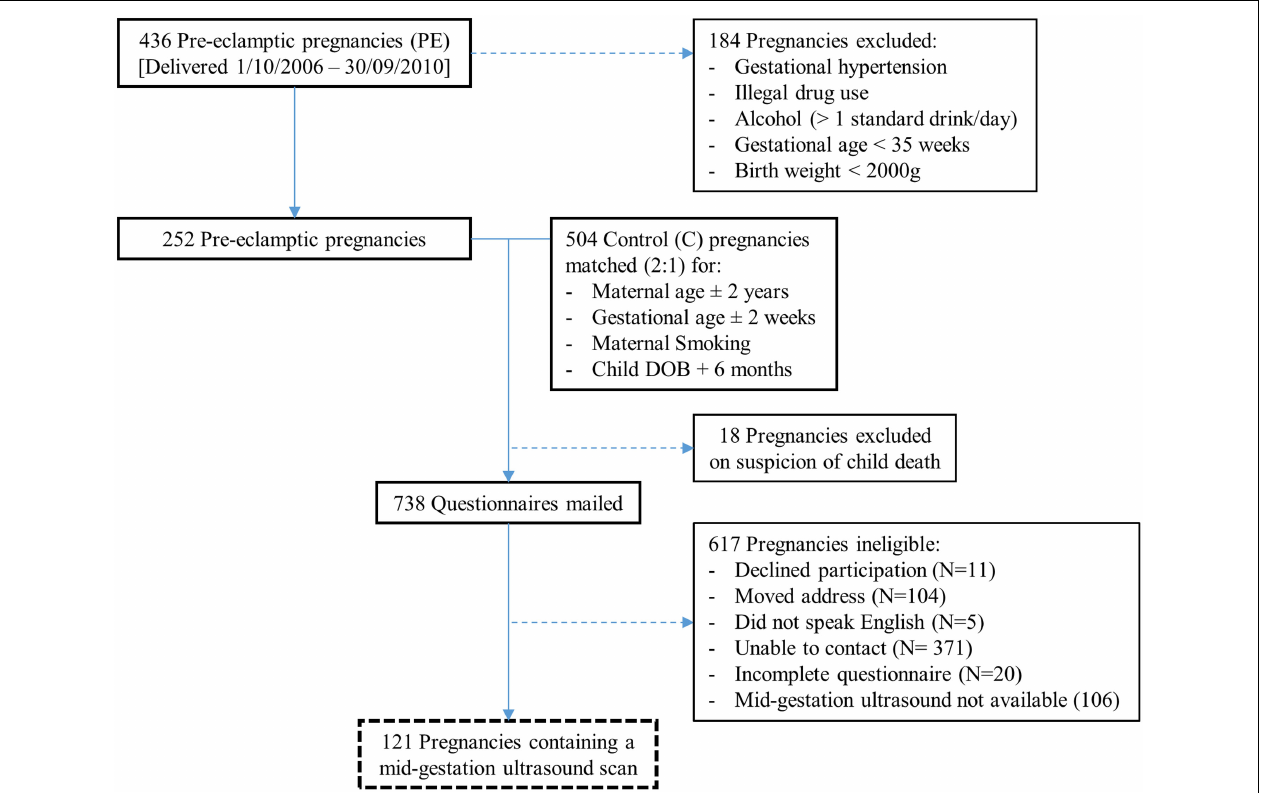
FIGURE 1 | Flow of pregnancies for inclusion .